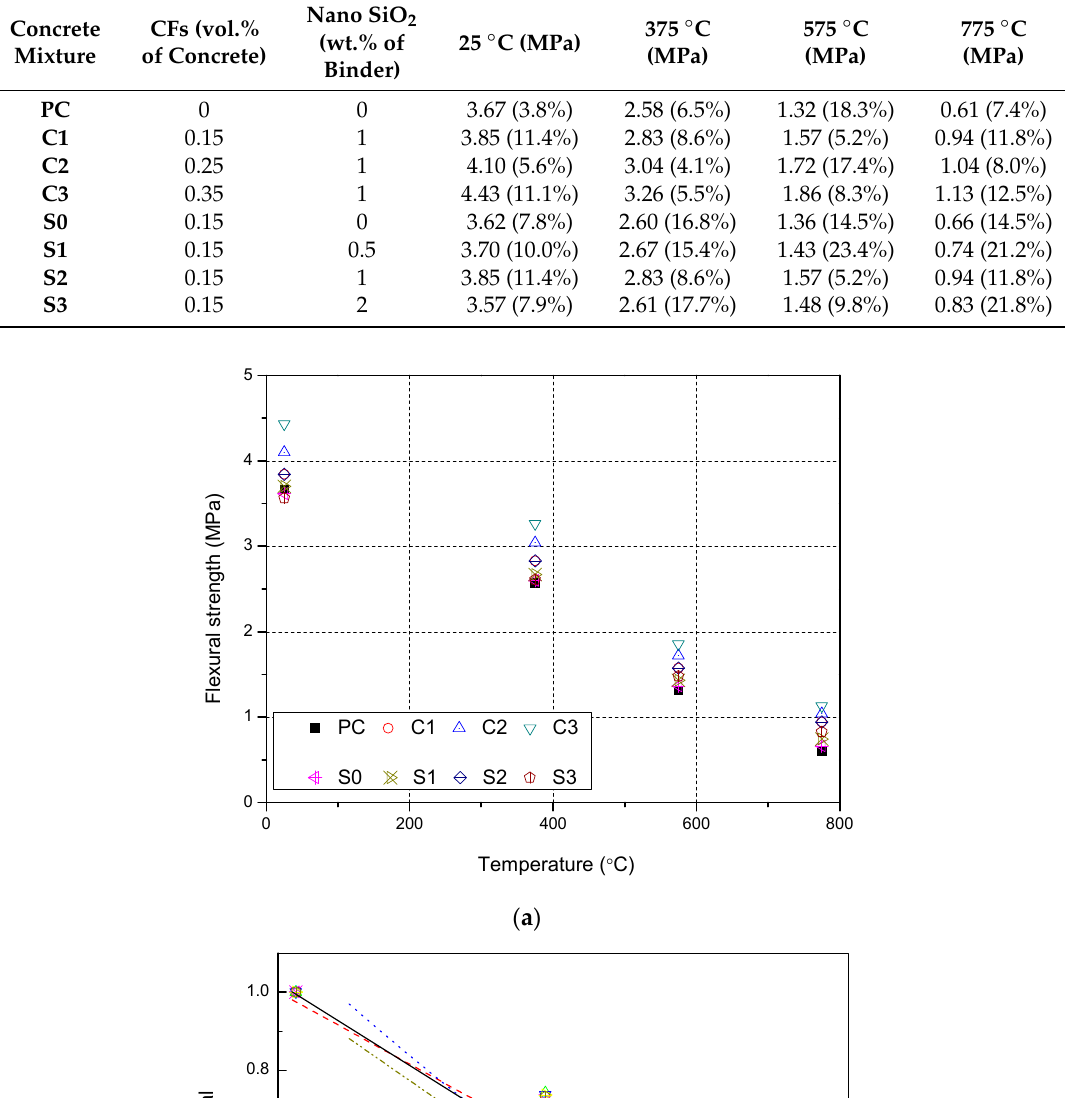
Table 6. Flexural strength of di ff erent NSCFRC after high-temperature.